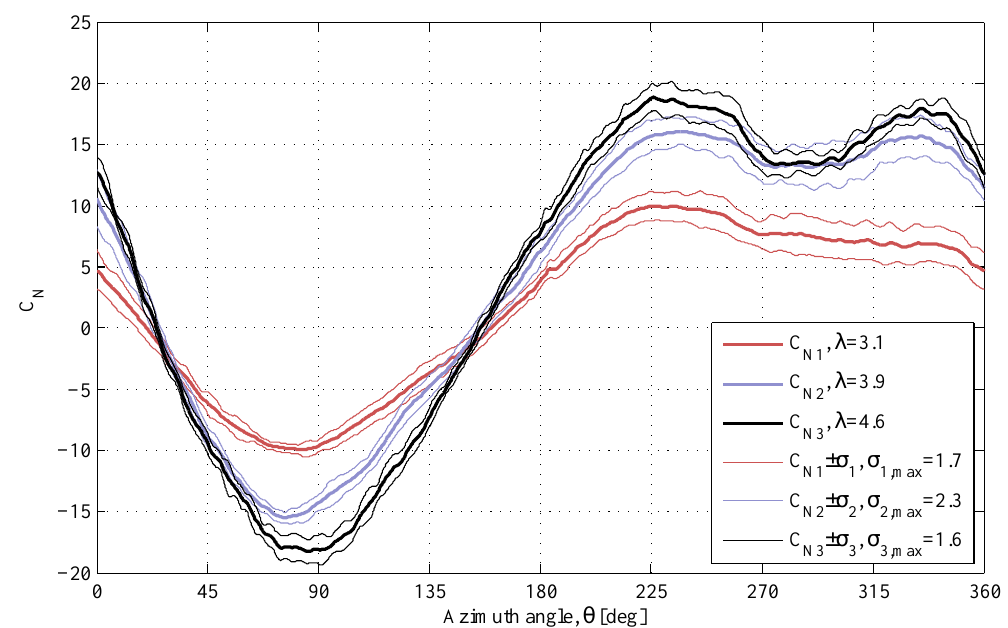
, which have higher variations than the ∞